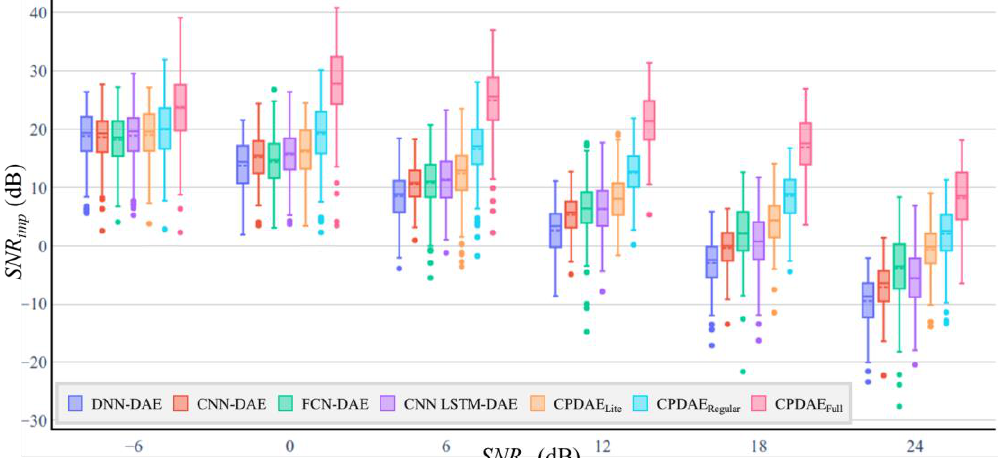
Figure 11. Box plots for SNR imp comparison of the denoising criteria of all of the evaluated methods under six SNR in for the testing phase of NSTDB; the box plots include outliers (dot), minimum, interquartile range, median, maximum, and average (dotted line).